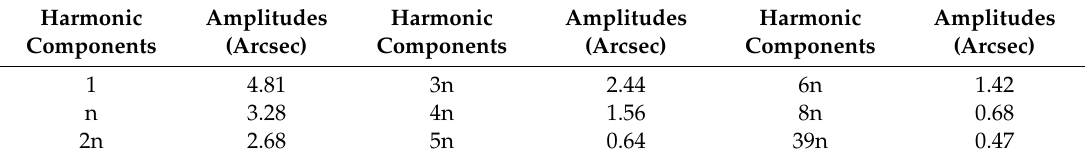
Table 4. Main harmonic components of the test TE.